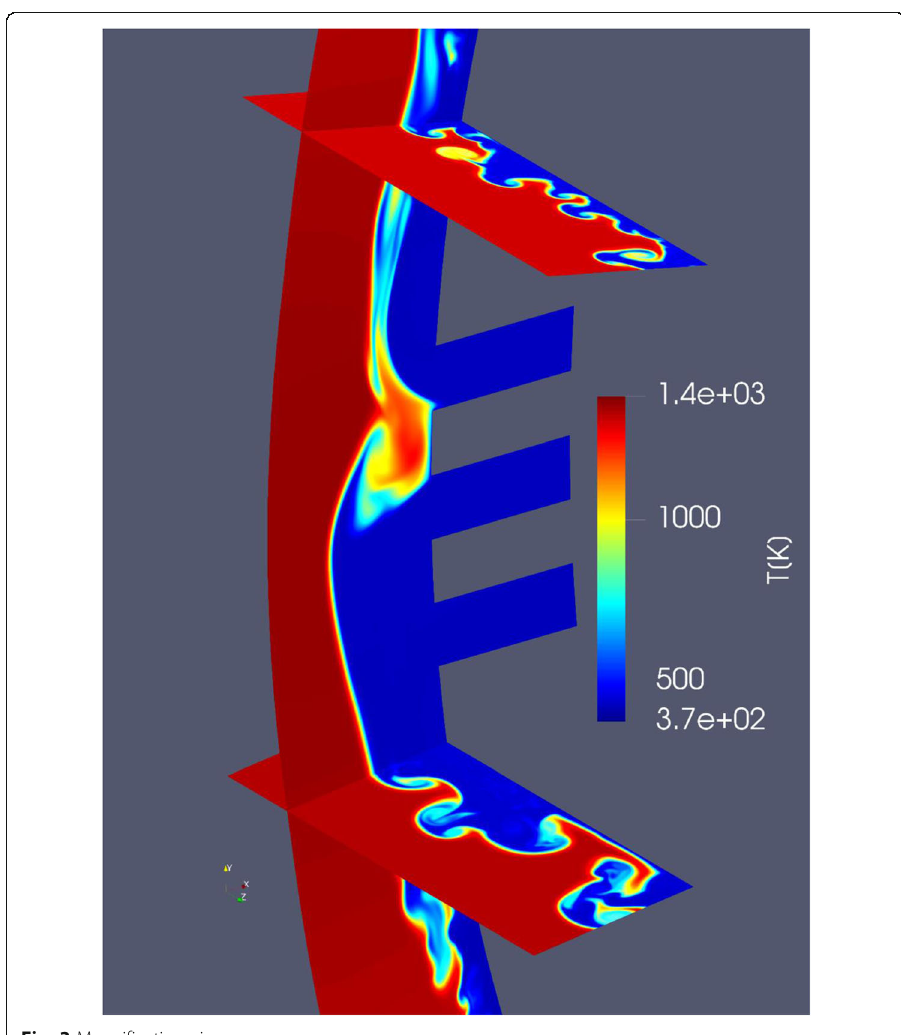
between two longitudinal rolls (right: clockwise, left: counterclockwise) is dragged to- wards the cylinder surface; the high temperature air is further dragged into the bottom of the (turbulent) boundary layer around z = 27 [mm] and the heat flux exceeds the value in the case without TPS there. A snapshot (Point A) of the longitudinal sectional view of the flow field at z = 5 [mm] is shown in Fig. 8. A longitudinal vortex roll is lo- cated on the left side of the middle jet and high temperature air is dragged between them; three separation bubbles are formed just downstream of the three jets and the corresponding jet boundaries act as the separated shear layers of these bubbles. The structure of these separation bubbles is not two dimensional; the formation of two- dimensional KH vortex rolls was not confirmed although some spanwise vortices were locally observed around the separated shear layer of the upper bubble. A stagnation re- gion is formed inside the middle bubble. Early breakdown to turbulence (bypass transi- tion) was clearly confirmed inside the lower separation bubble. Turbulent boundary layers were developed downstream of the upper and lower bubbles. Figure 9 shows the distribution of the circumferential velocity in the vicinity of the upper cylinder